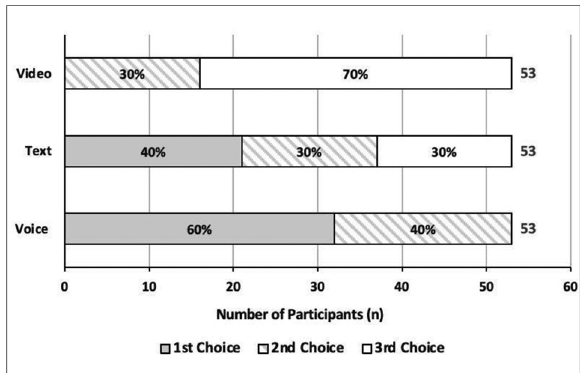
FIGURE 3 Participants ’ relative preferred modalities of communication using their mobile